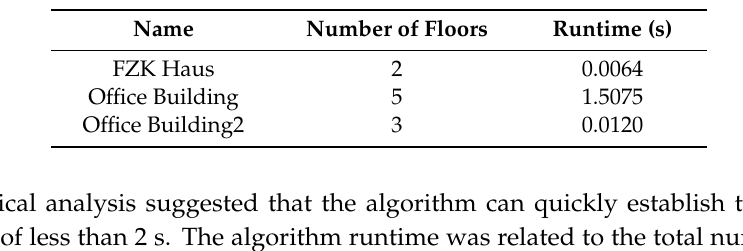
Table 4. Runtime of the floor relation extraction algorithm at di ff erent models.